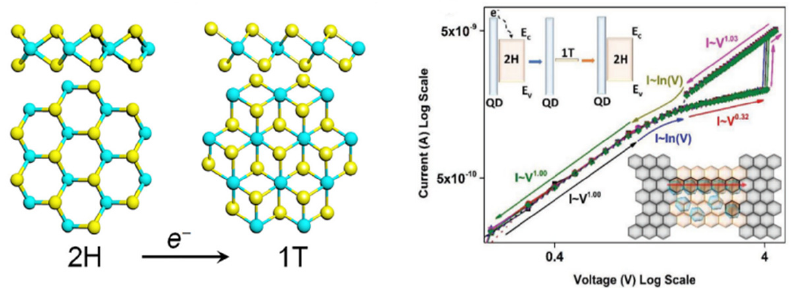
Figure 13. Crystal structure of MoS 2 ( left ). Atoms in the lattice: molybdenum—yellow, sulfur—blue. Phase transition in MoS 2 from a trigonal prismatic (D3h) to an octahedral (Oh) structure, induced by a negative charge. Current–voltage characteristic of the 2D MoS 2 0D QD structure with graphene electrodes on a logarithmic scale ( right ). The inset at the top schematically shows a diagram of the photoexcited electron transfer process and the corresponding charging and discharging processes leading to 2H-1T phase transitions. The inset below shows a diagram of the formation of a filamentous channel from phase 1T. Graphene, 2H-MoS 2 , 1T-MoS 2 , and MoS 2 QDs are displayed in gray, light yellow, brown, and blue, respectively.